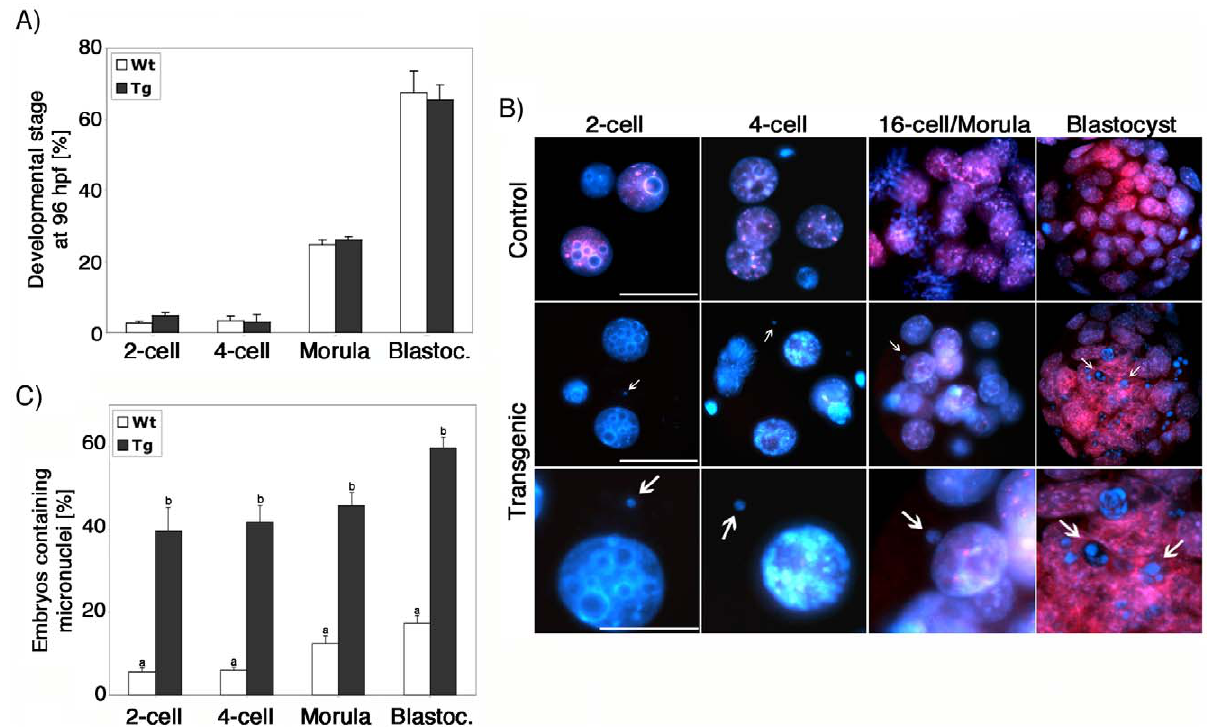
Figure 8. Lack of ATRX function during oogenesis results in severe genomic instability in the pre-implantation embryo. ( A ) Developmental potential of ATRX deficient oocytes. Control and transgenic oocytes exhibit similar rates of blastocyst formation at 96 hours following in vitro fertilization (hpf). ( B,C ) Presence of micronuclei throughout pre-implantation development in ATRX deficient embryos. Although ATRX protein can be detected at the 8–16 cell stage following fertilization of ATRX deficient oocytes, a high proportion of ATRX deficient embryos exhibit micronuclei formation (arrow) as evidence of chromosome instability at all stages evaluated. Data are presented as the mean 6 s.d. of three independent experiments. Scale bar =10 m